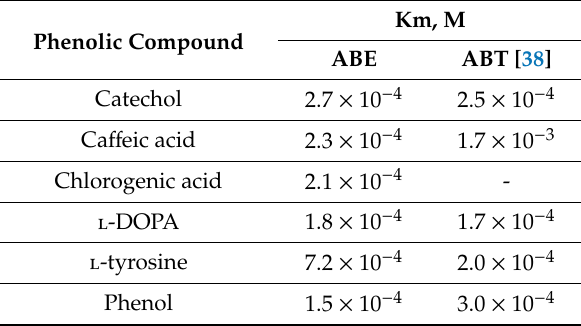
Figure 5. Lineweaver–Burk plot for l -DOPA. pH = 7.2, ABE activity 265 U, reaction speed (v, min − 1 ) is (A 270 s − A 30 s ) / 4. Table 4. Michaelis constants (K m ) for crude Agaricus bisporus extract (ABE) and isolated tyrosinase from Agaricus bisporus